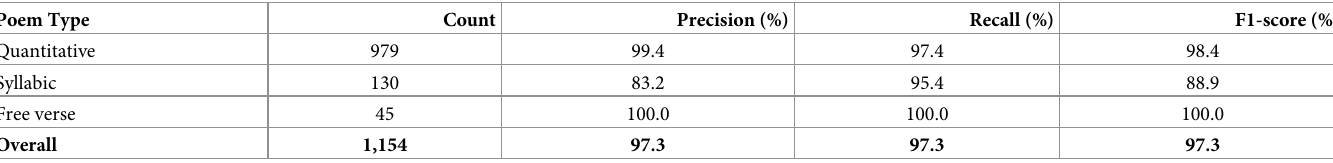
Table 7. Test Results for poem-type classification. Poem Type Count Precision (%) Recall (%) F1-score (%)